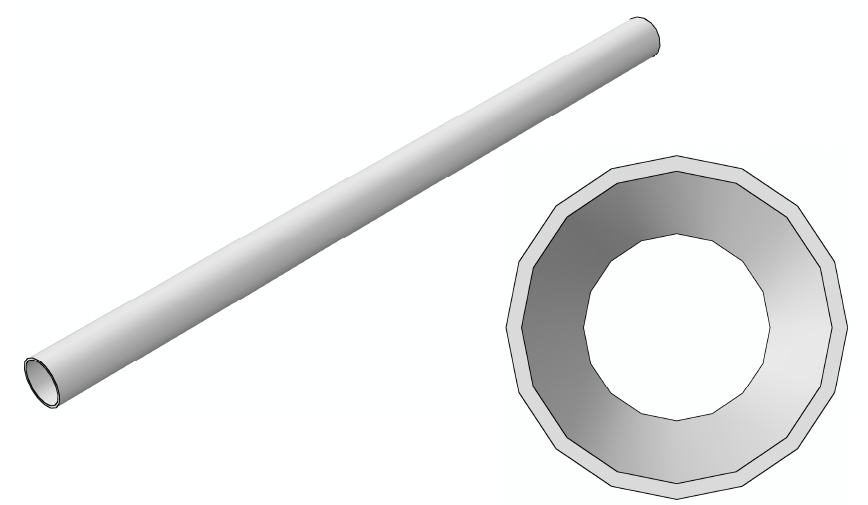
Figure 6. Geometry model of a hydraulic pipe.